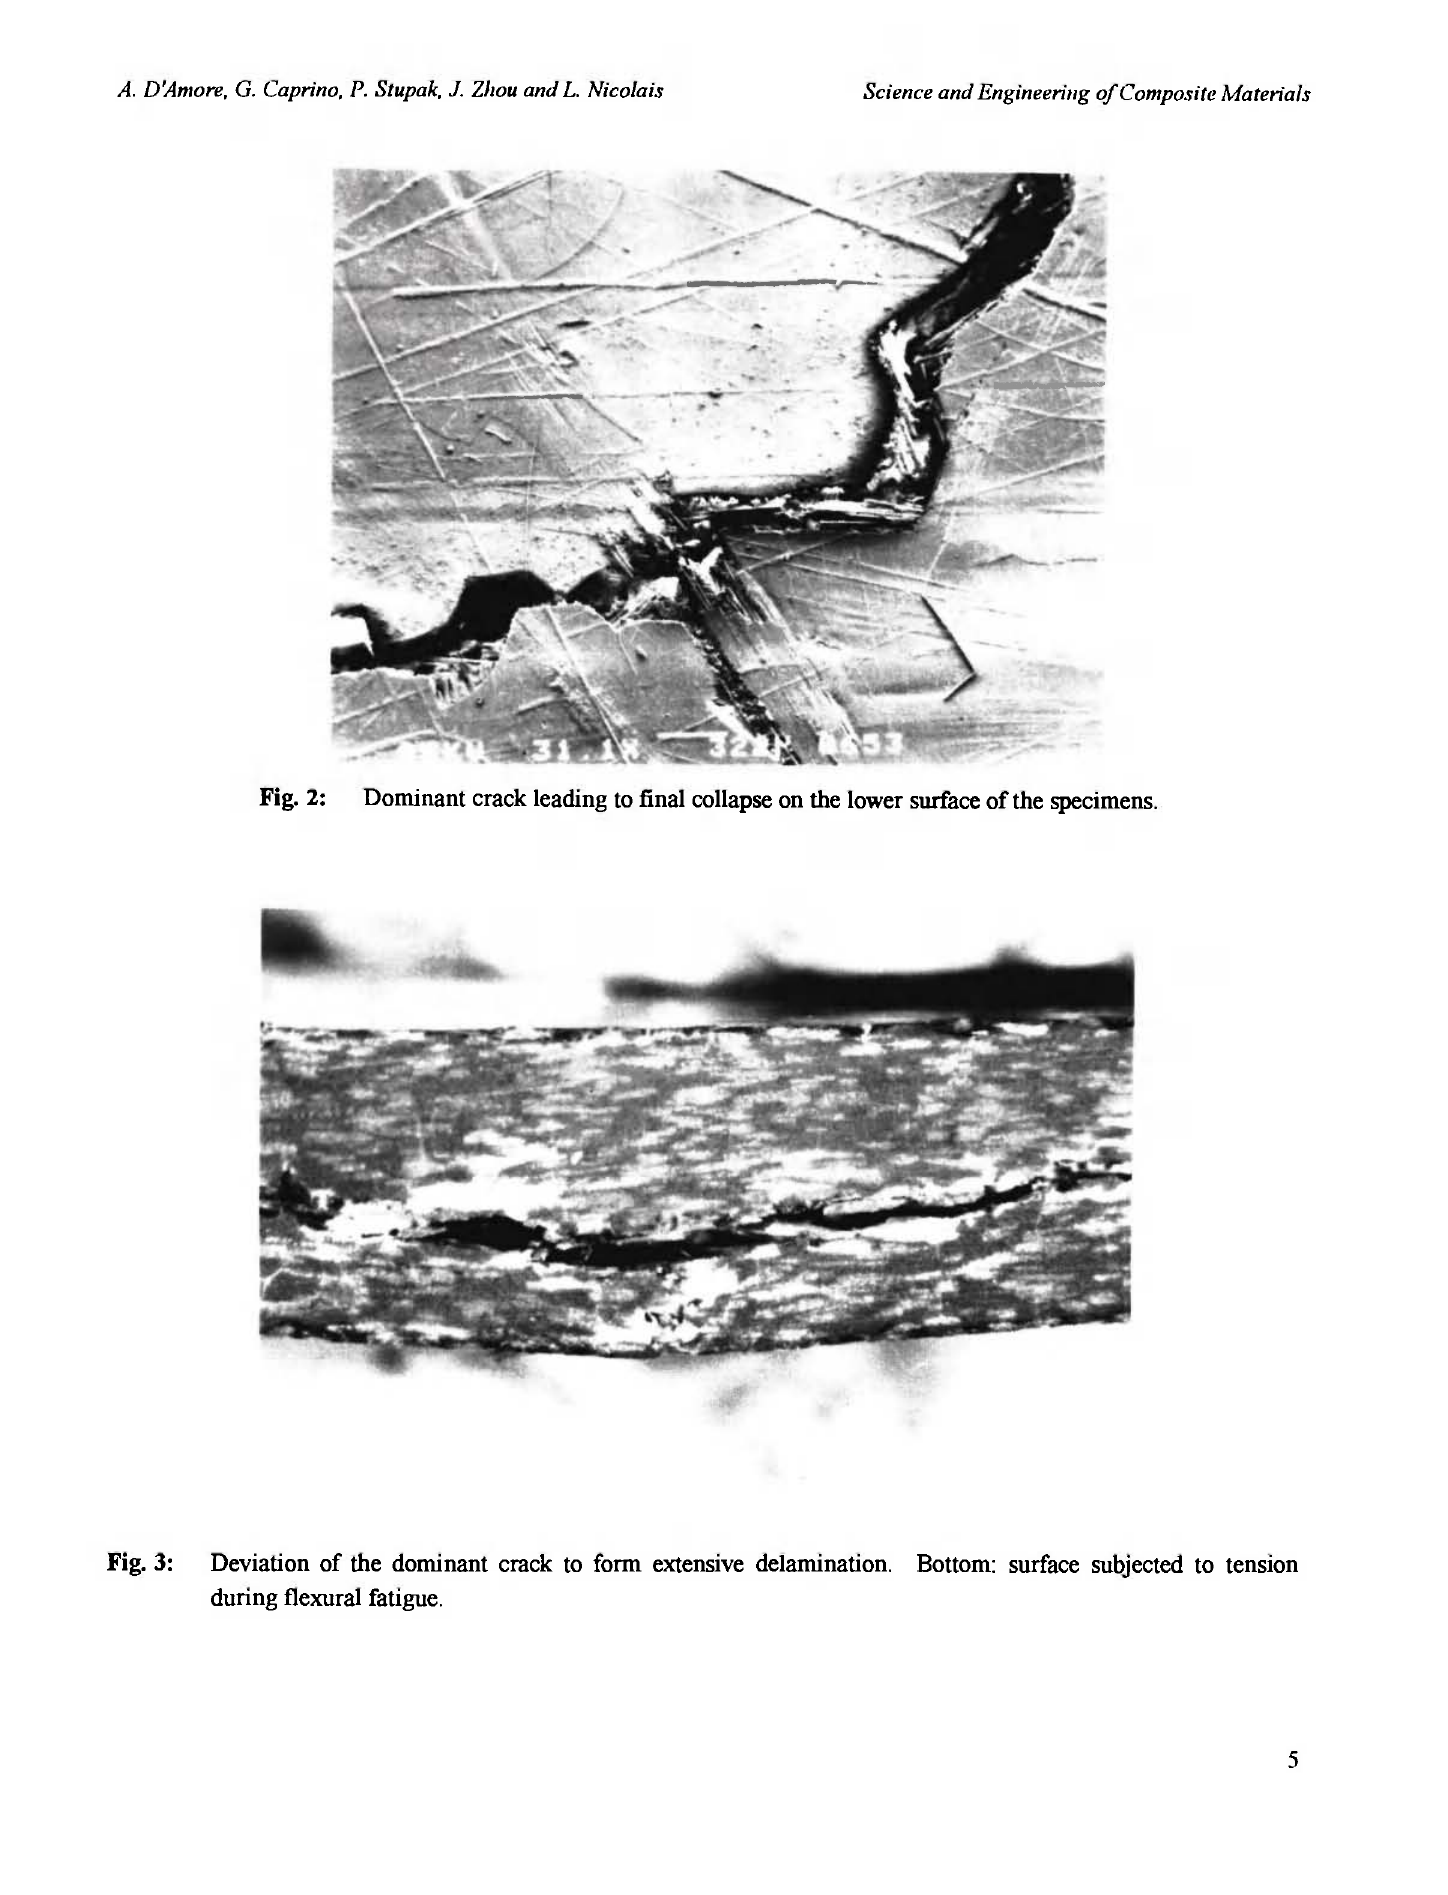
Fig. 3: Deviation of the dominant crack to form extensive delamination. Bottom: surface subjected to tension during flexural